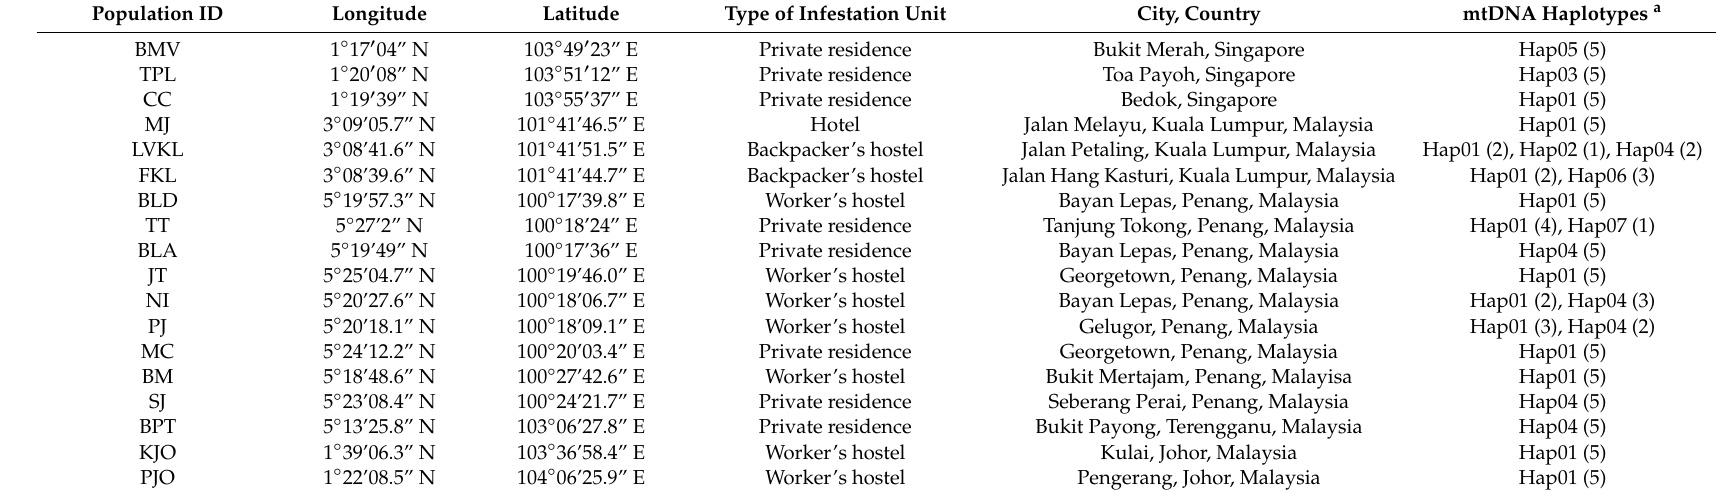
Table 1. Samples location and the types of molecular markers used in the